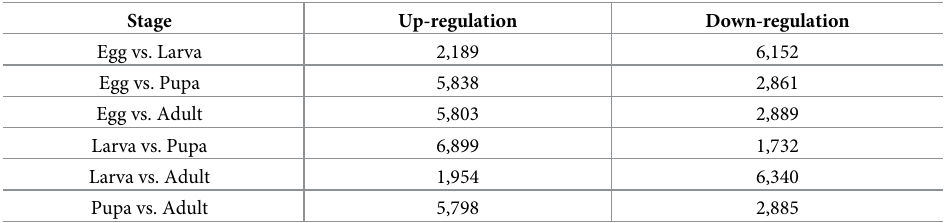
Table 3. Number of differentially expressed genes in P. b. seulensis